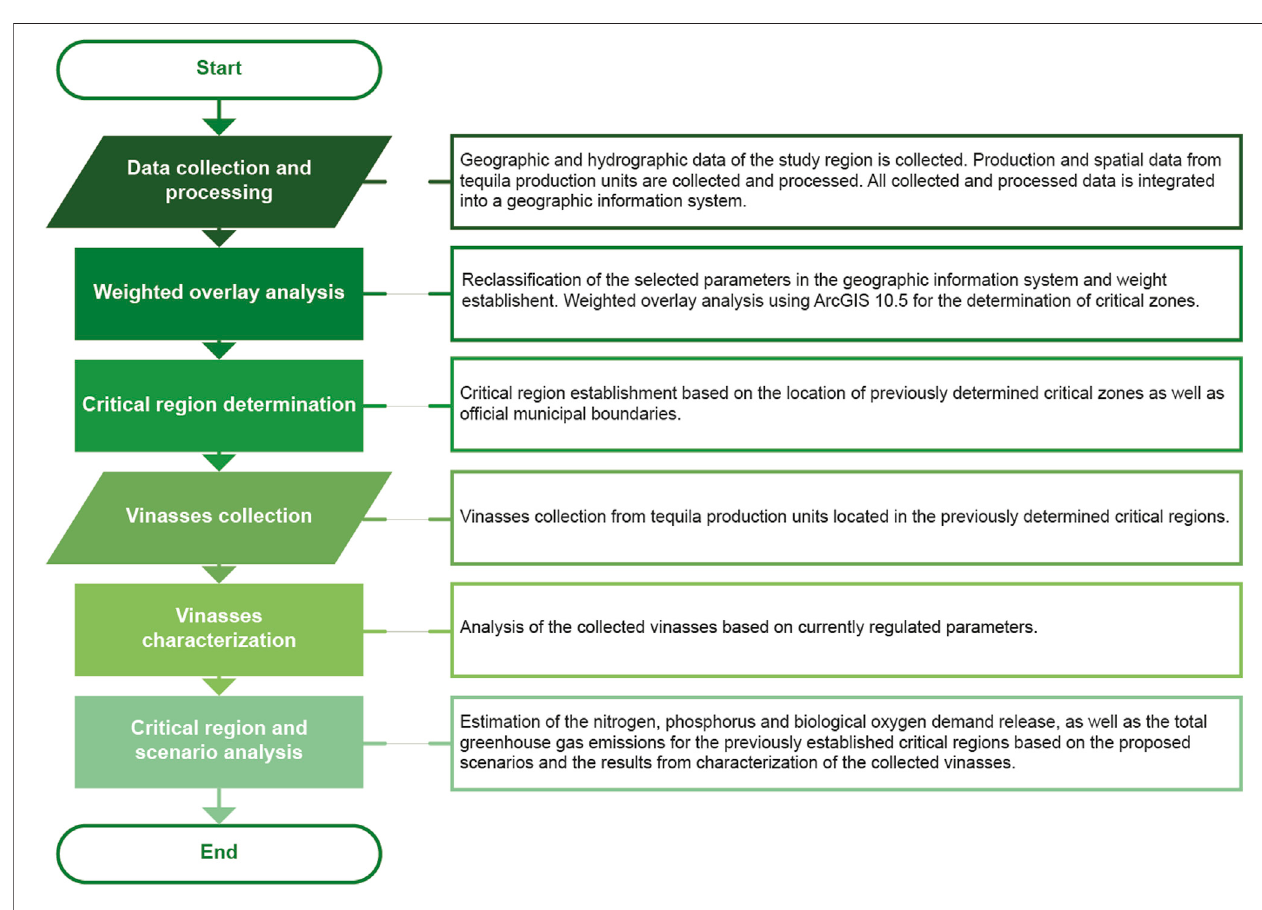
FIGURE 2 | The general methodology used in this study.